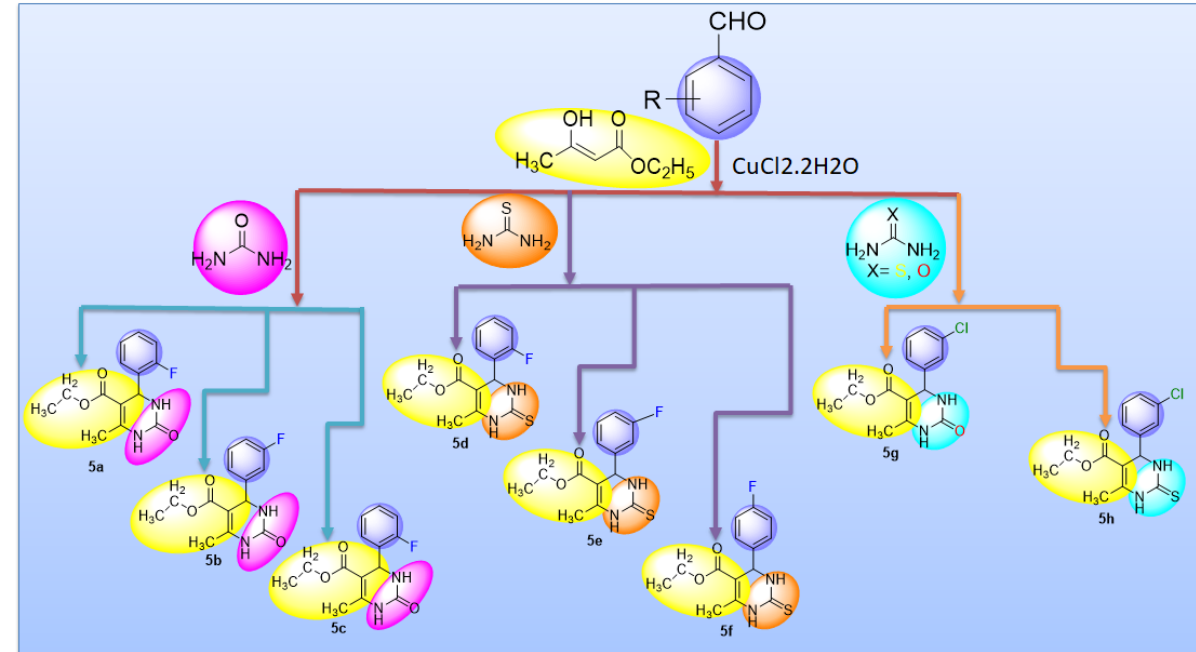
Figure 16. General equation for synthesis of compounds ( 5a – h ).